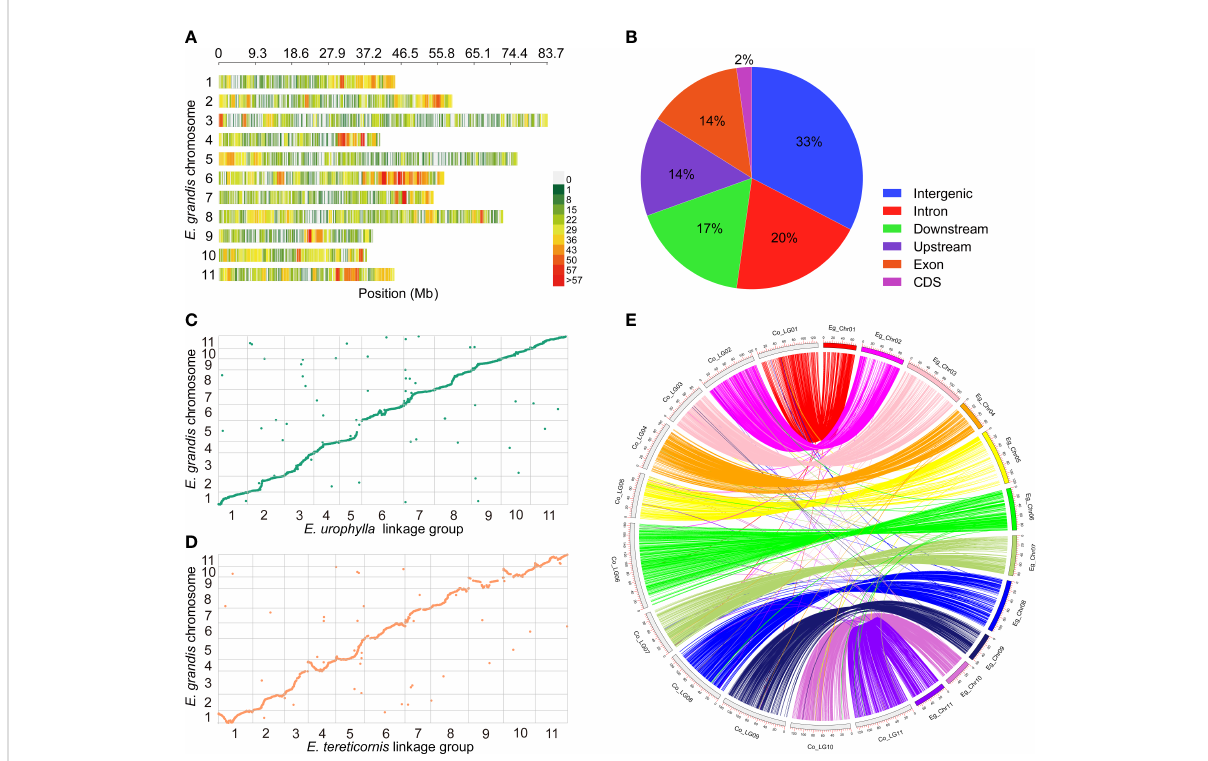
FIGURE 2 SNP calling and genetic mapping construction. (A) Distribution of SNP loci on the chromosomes of E . grandis . (B) Genomic position of SNP loci. Syntenic and colinear relationships of each LGs of E . urophylla (C) and E . tereticornis (D) with E . grandis genome sequence. In (E) , the curve with the same color represents a similarity match between the chromosomes of E . grandis (e.g., Eg_Chr01) and the corresponding linkage groups of the consensus map (e.g.,